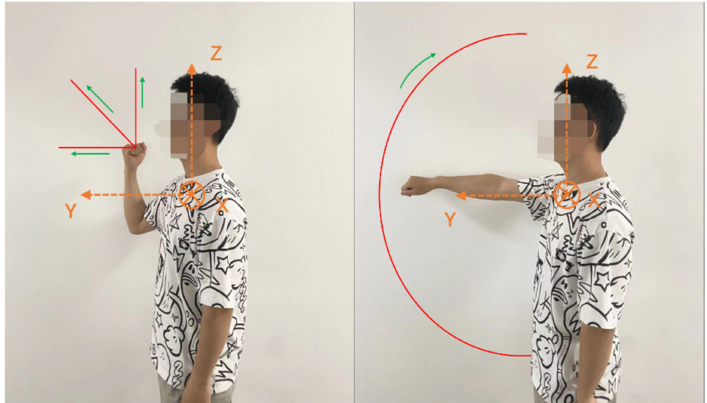
Figure 9. Four preset trajectories